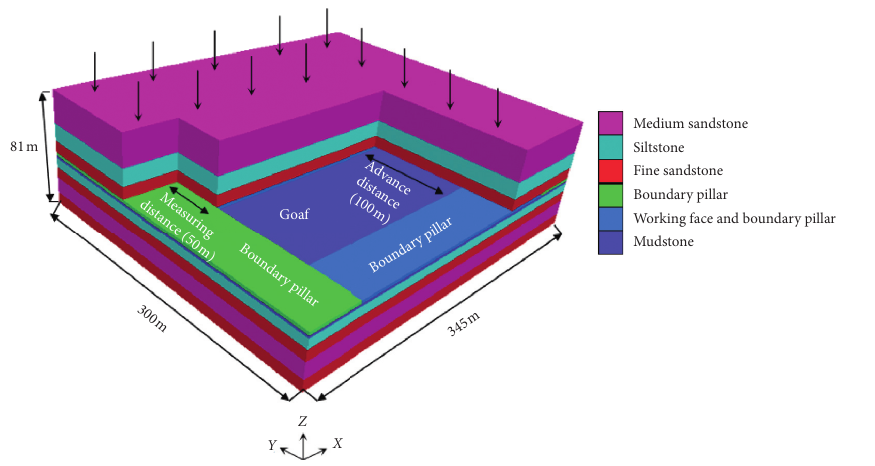
Figure 4: Numerical simulation model. Table 4: Design of different face-advance